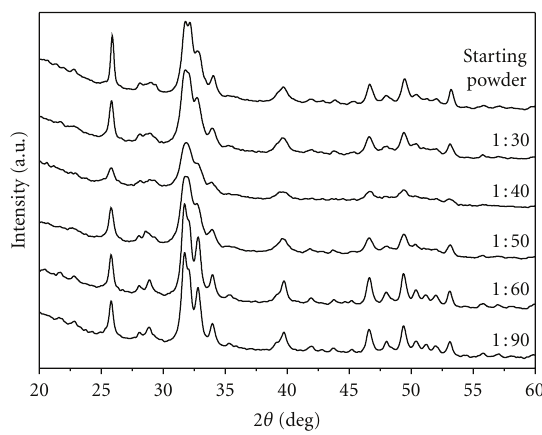
Figure 1: XRD patterns of hydroxyapatite powder milled one hour for various W p : W b